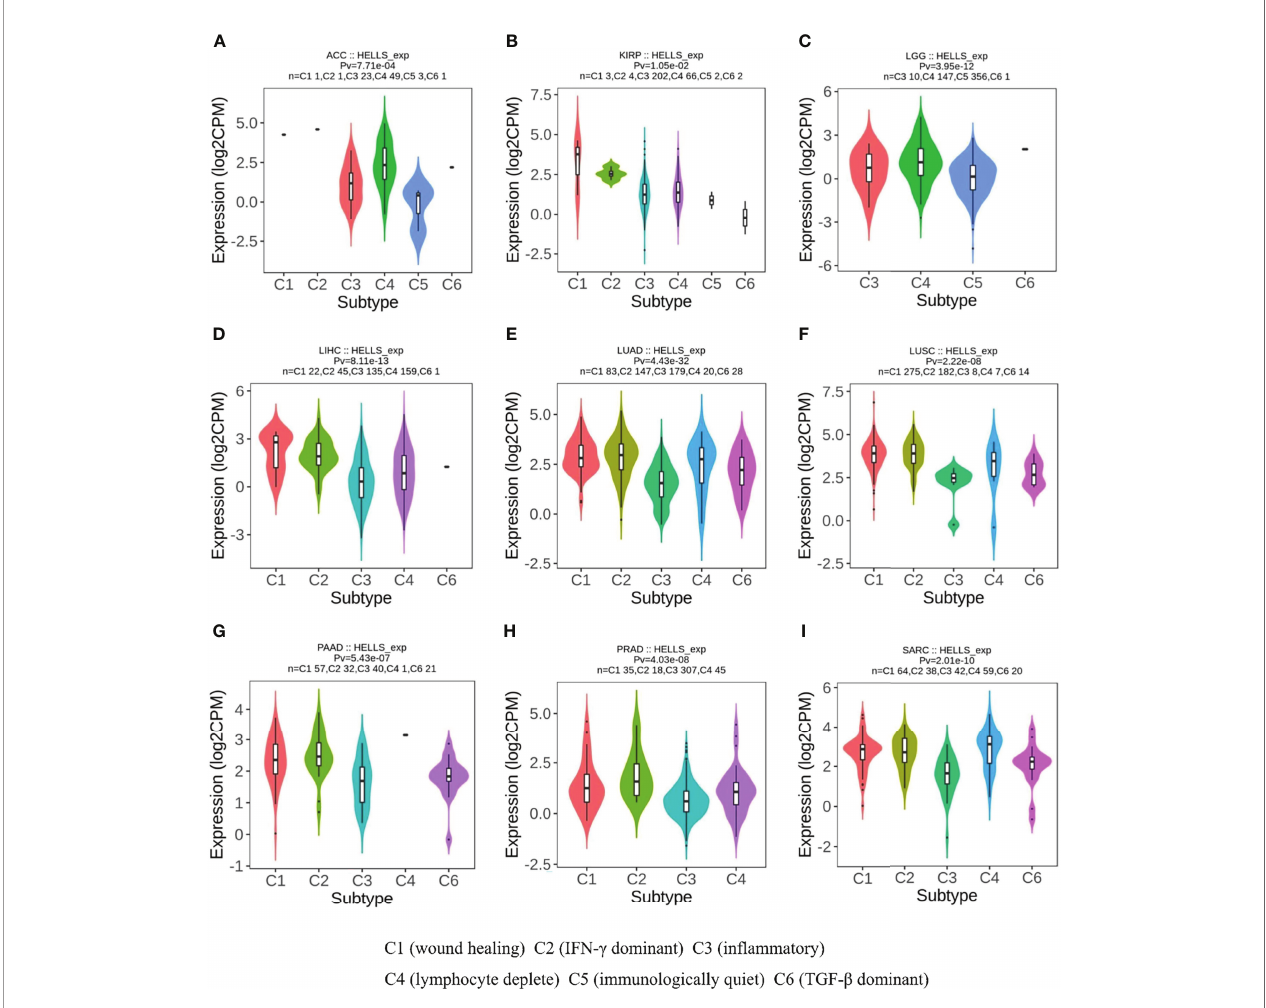
FIGURE 6 | Correlations between HELLS expression and immune subtypes in 9 cancers. (A) ACC, (B) KIRP, (C) LGG, (D) LIHC, (E) LUAD, (F) LUSC, (G) PAAD, (H) PRAD, (I) SARC. C1 (wound healing), C2 (IFN- g dominant), C3 (in fl ammatory), C4 (lymphocyte deplete), C5 (immunologically quiet), and C6 (TGF- b